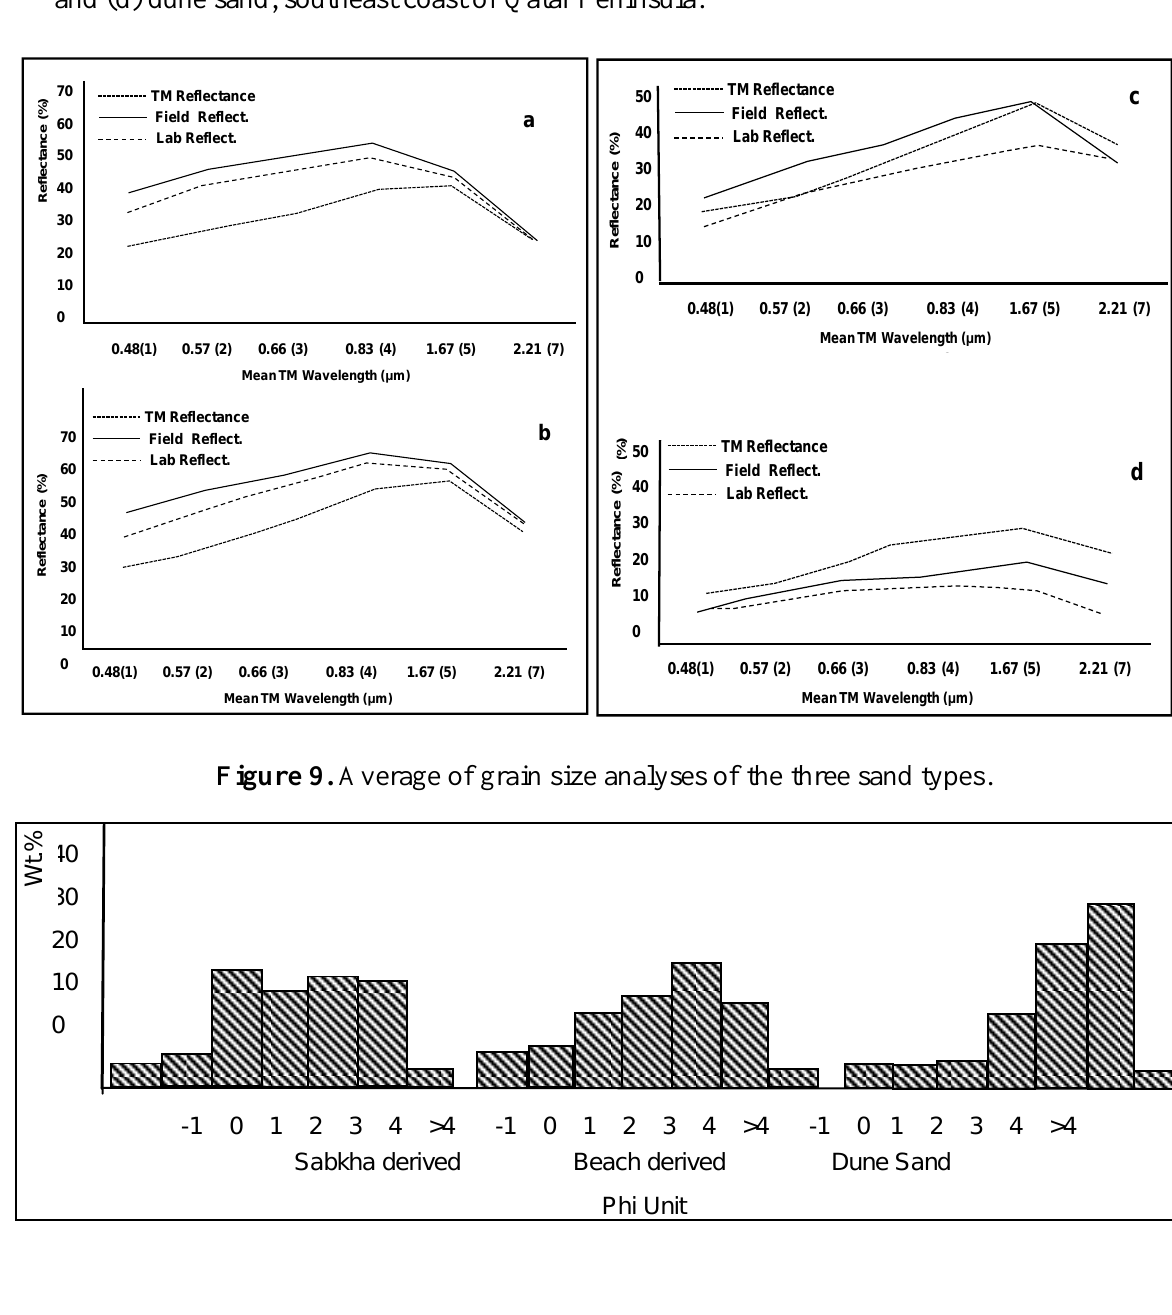
Figure 8. Mean spectral reflectances of: (a) Sabkha derived sand of west of Qatar and (b) beach-derived sand, northeast coast of Qatar Peninsula, (c) beach derived sand, north tip, and (d) dune sand, southeast coast of Qatar Peninsula.